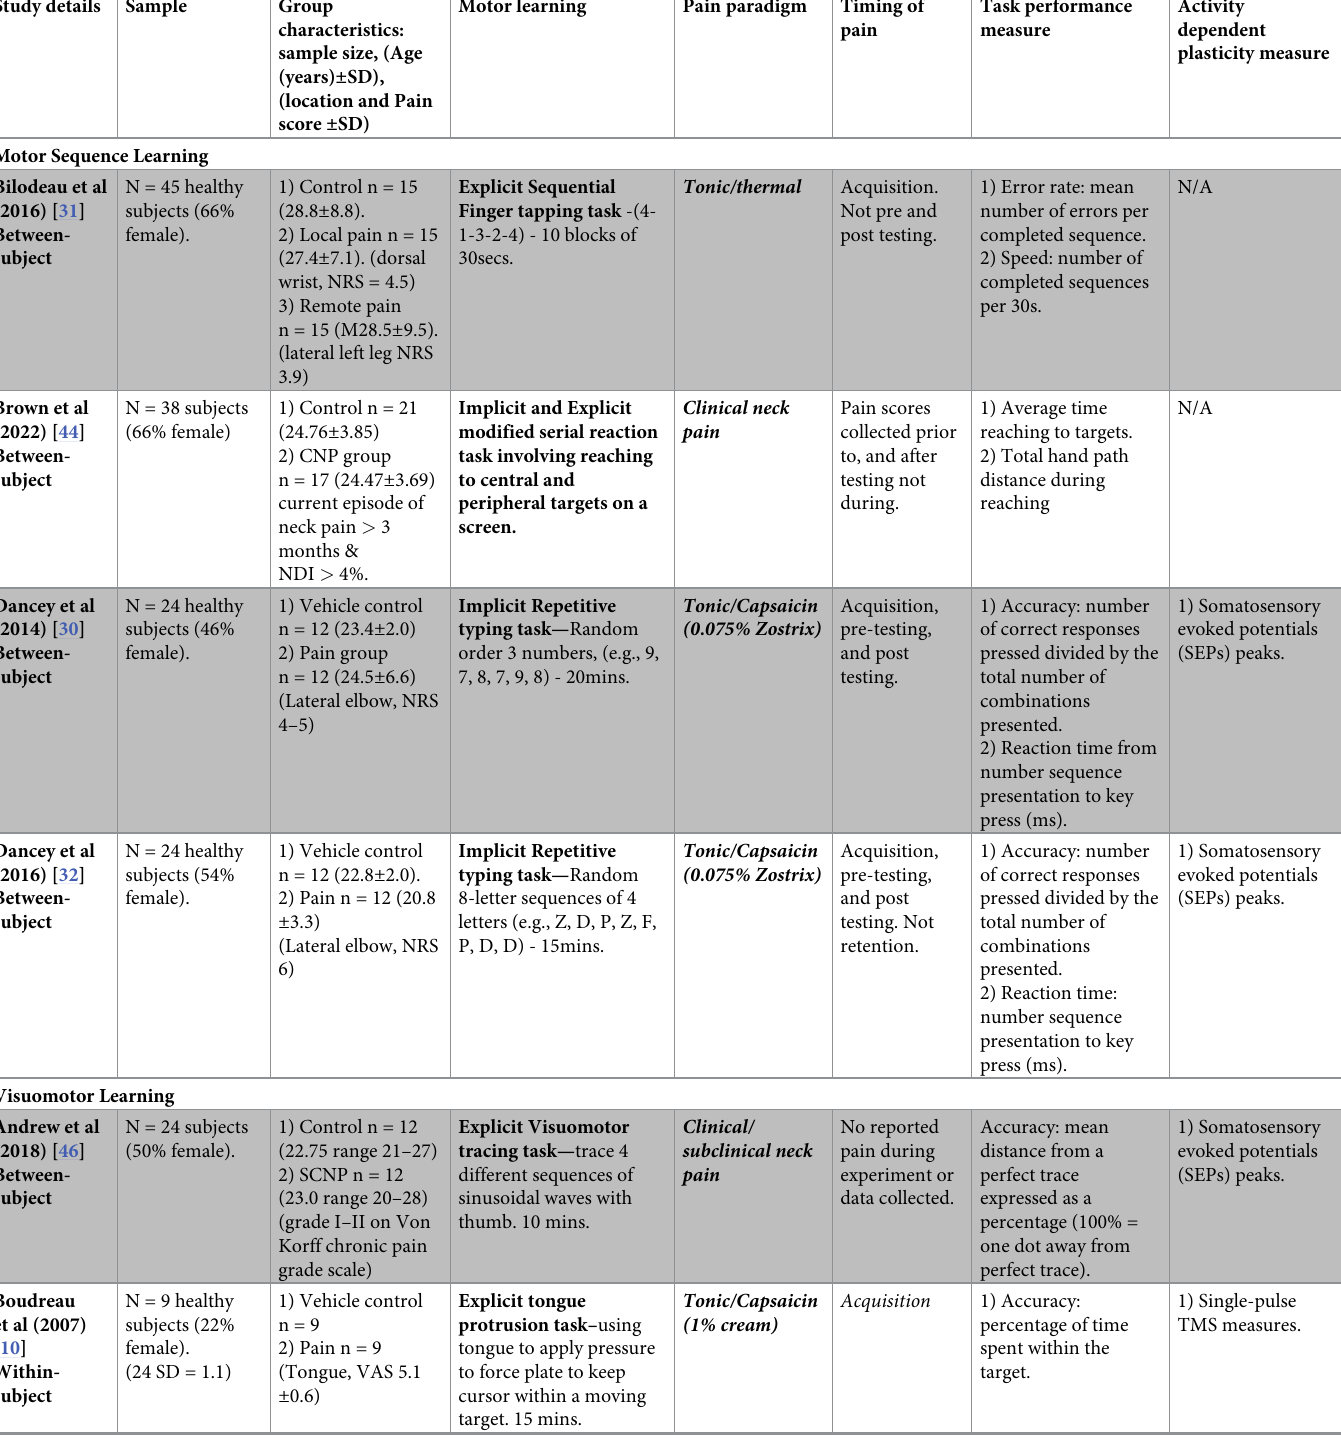
Table 2. Key characteristics of included studies listed in order of motor learning